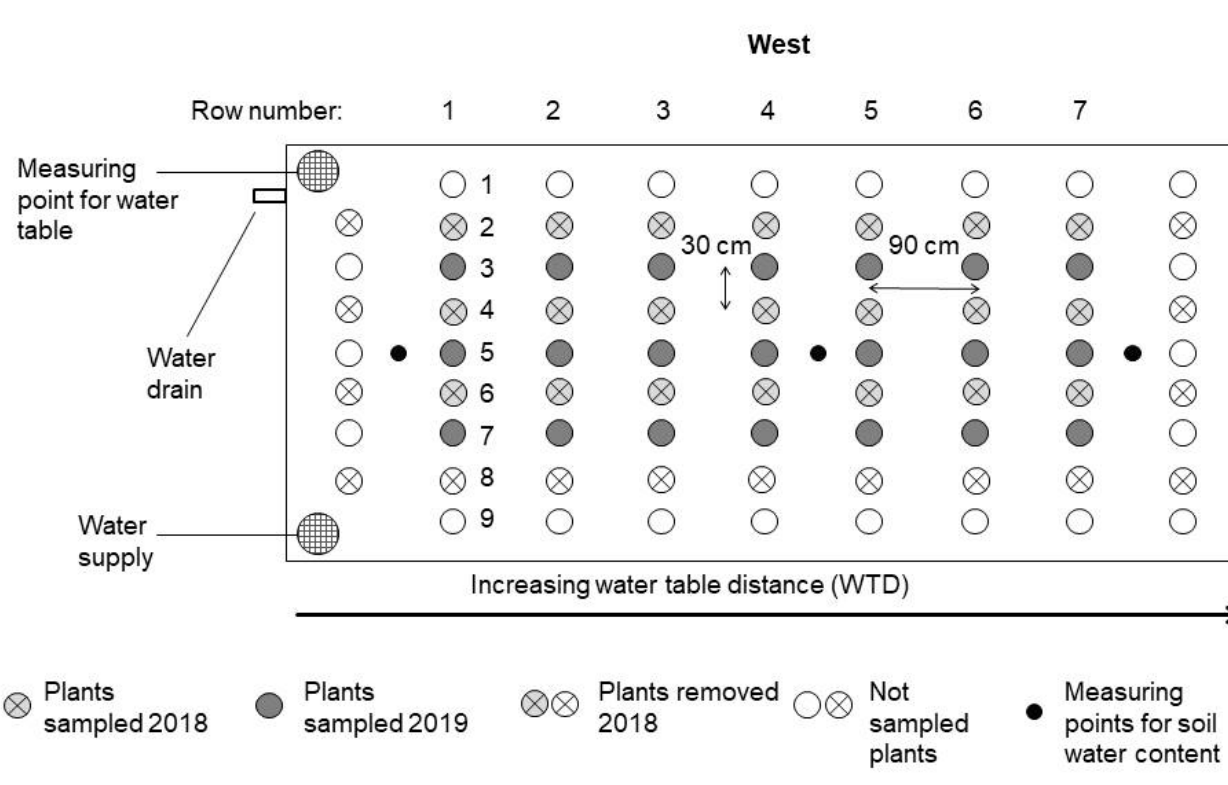
Figure 2. Top view of a groundwater tank indicating the plant arrangement, the harvesting scheme, and the measuring points for soil water content and water table.